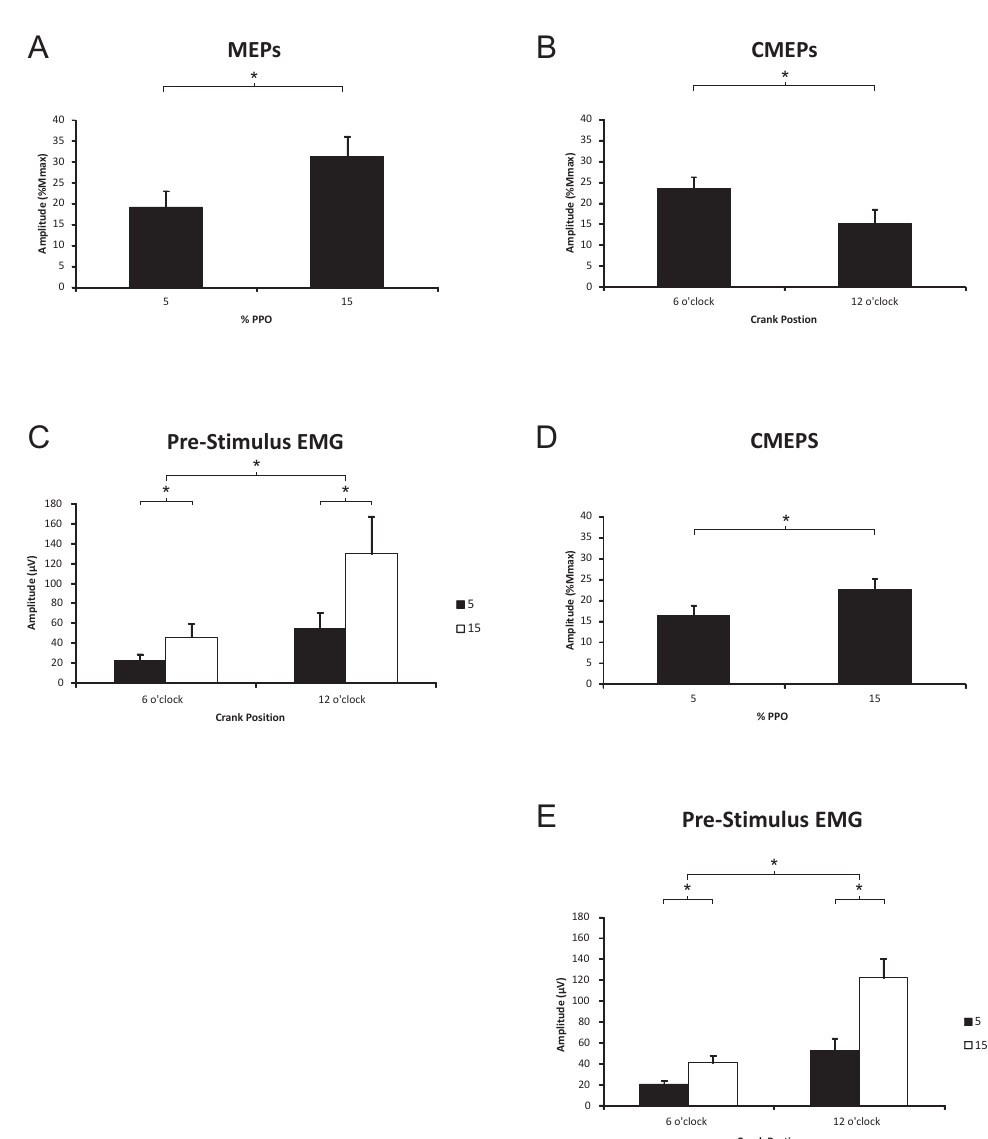
Figure 5. Group data (means ± SE, n = 12) for triceps brachii MEP amplitudes ( A ), and pre-stimulus EMG prior to transcranial magnetic stimulation (TMS; C ). Group data (means ± SE, n = 8) for CMEP amplitudes based on position ( B ) and % PPO ( D ), as well as pre-stimulus of the triceps brachii prior to TMES ( E ). MEP and CMEP amplitudes are expressed relative to the M max taken during cycling at the same cadence and workload. * Significant difference ( p < 0.05). Abbreviations are: MEP,